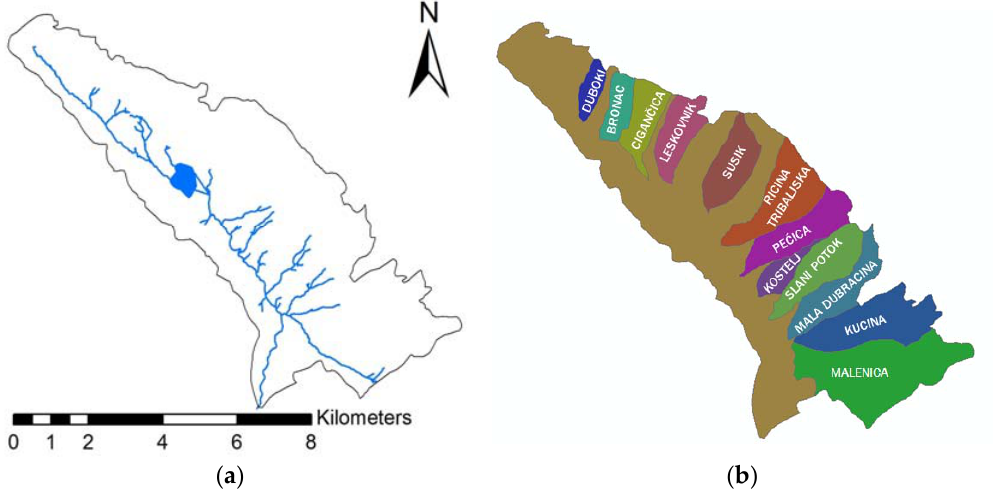
Figure 1. Dubra č ina catchment: ( a ) river network; ( b ) sub ‐ catchments. Table 1. Torrential tributaries length and sub ‐ catchment area. Tributary Area (km 2 ) River Length (km)